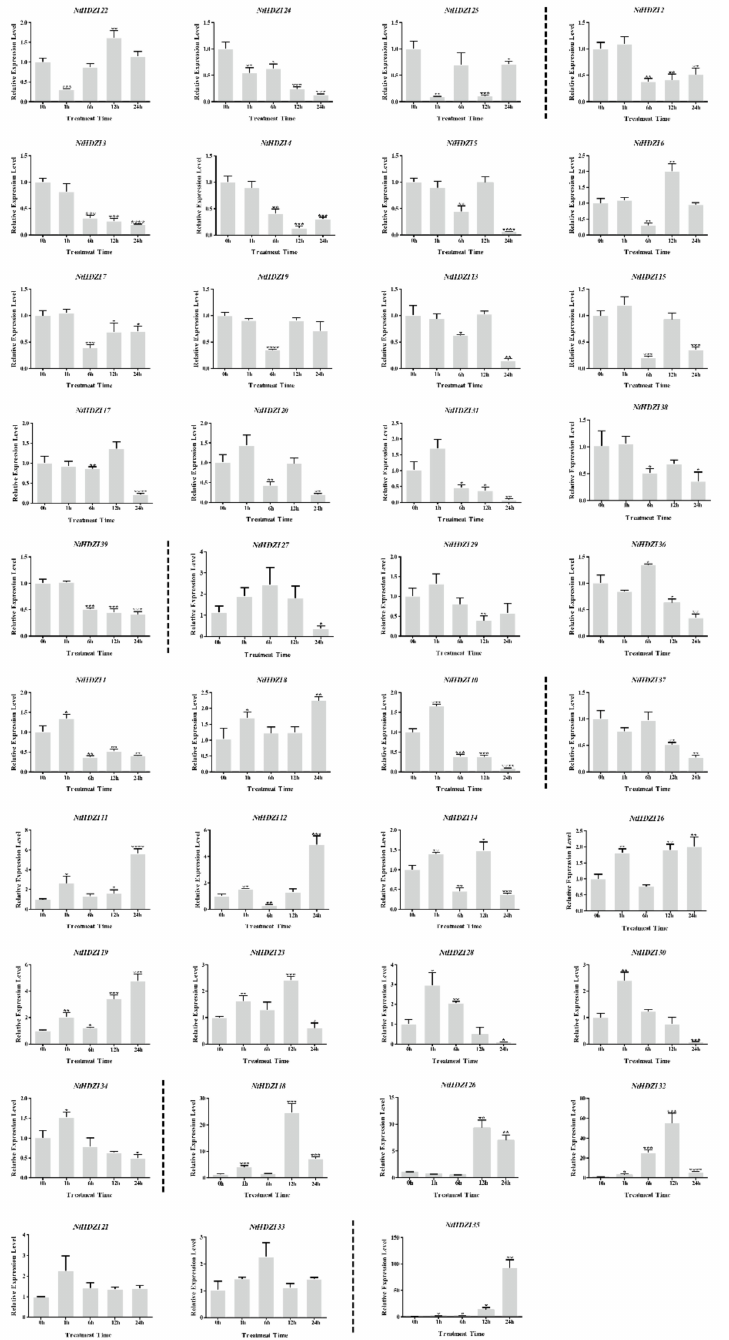
Figure 6. The expression levels of 39 NtHD-Zip I genes in N. tabacum under low-temperature (4 ◦ C) treatment. Bars represent the mean values of three replicates ± standard deviation (SD). All of the expression levels of the NtHDZI genes were normalized by the expression levels of NtEF1 α . Untreated leaves (0 h) were normalized as “1” at each graph.****, ***, **, and * indicate significant di ff erence compared to the control (0 h) at p < 0.0001, p < 0.001, p < 0.01, and p < 0.05,